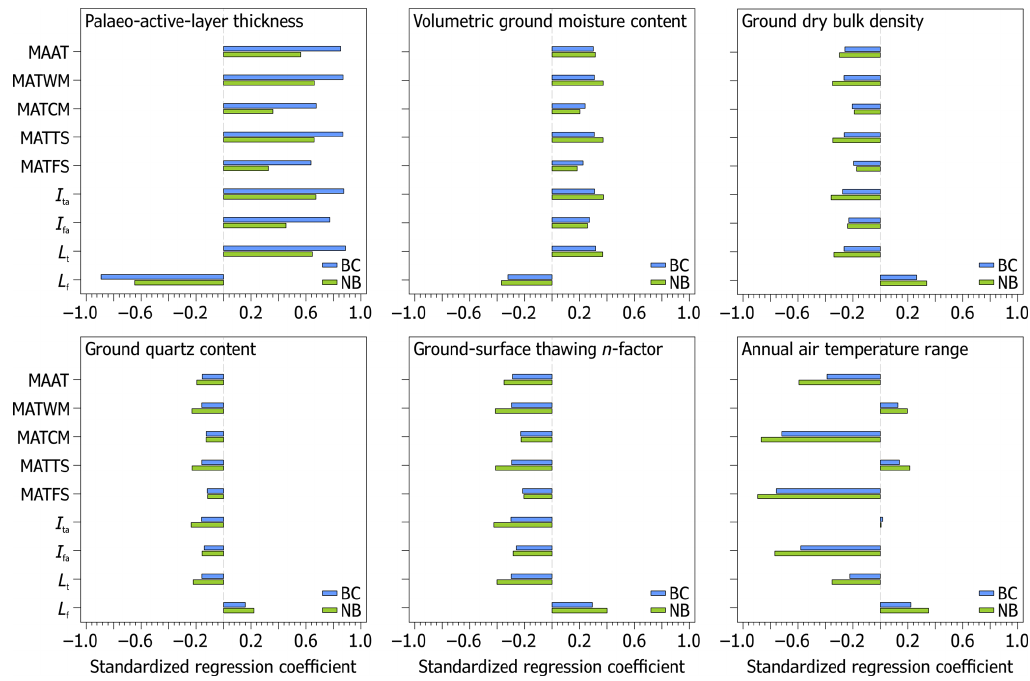
Figure 7. Sensitivity of the modelled palaeo-air temperature characteristics at the Brno–ˇCernovice (BC) and Nebanice (NB) sites to individual model input variables expressed by standardized regression coefficients. See the text and Table 1 for